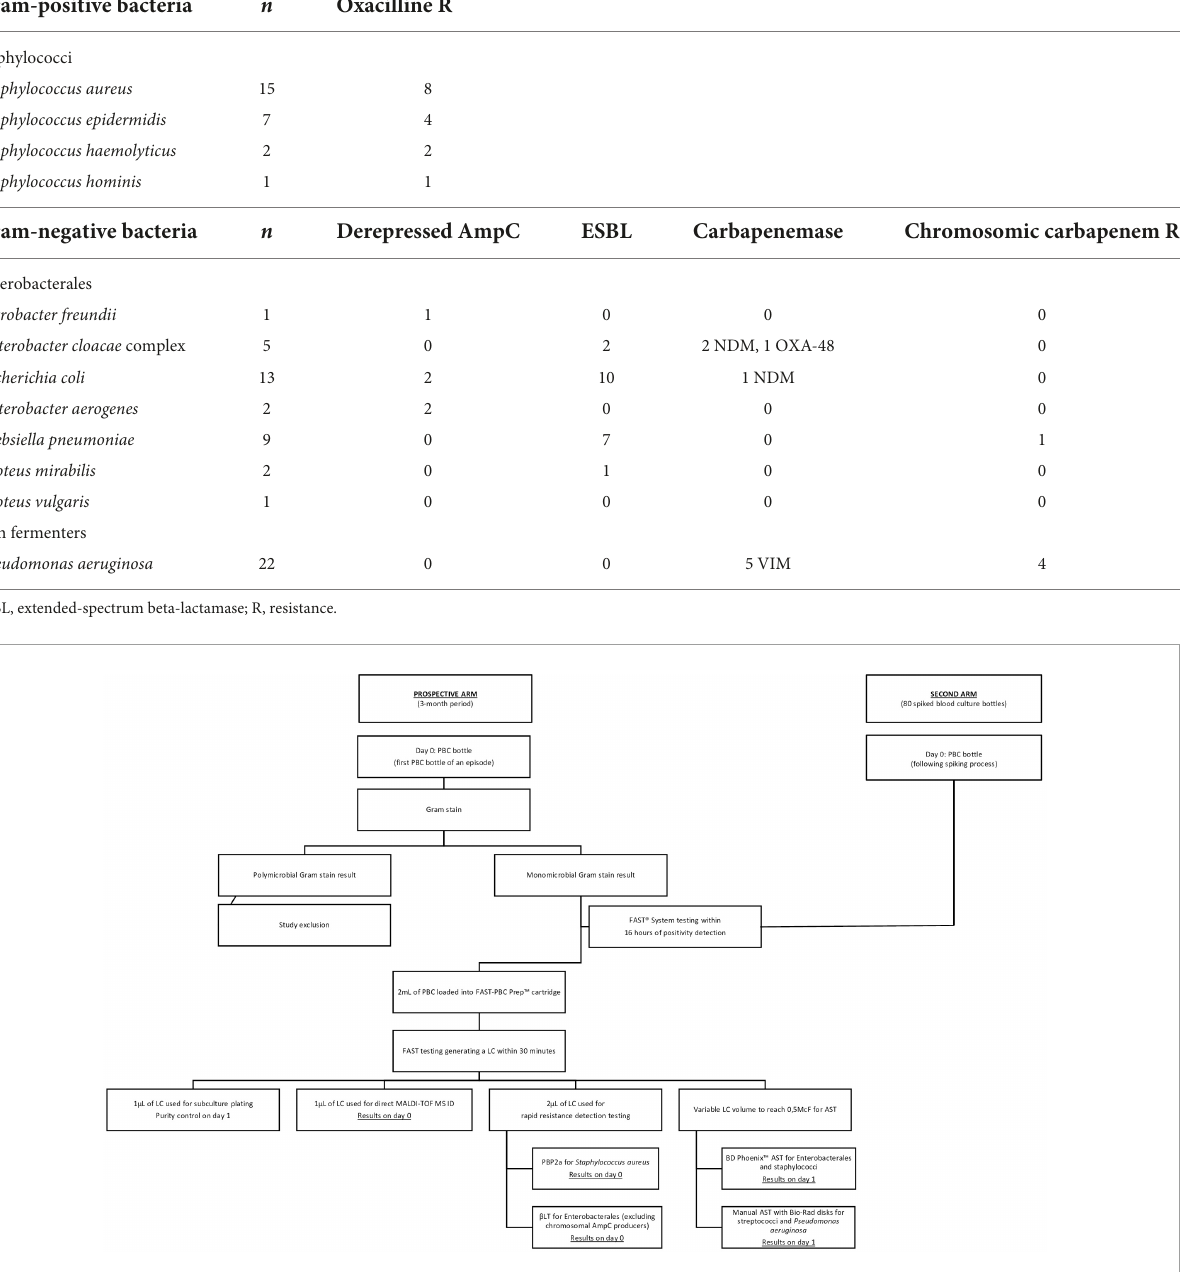
FIGURE1 FAST TM System testing flowchart. AST, antimicrobial susceptibility testing; ID, identification; LC, liquid colony; PBC, positive blood culture; PBP2a, Clearview TM PBP2a SA Culture Colony Test; β LT, β LACTA